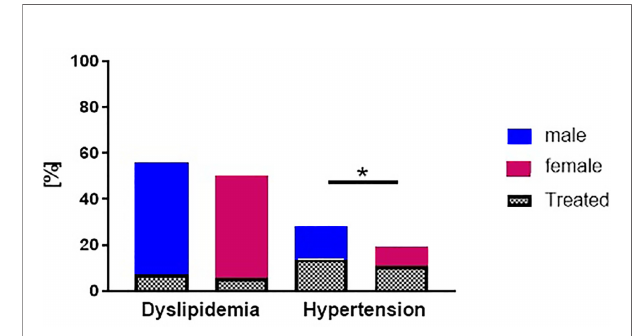
FIGURE 2 | Glucose-lowering medication in patients with newly diagnosed type 1 diabetes from the GDS and DPV cohorts. Choice of glucose-lowering medication in patients with newly diagnosed type 1 diabetes from the GDS (black) and DPV (grey) cohort. Data was collected on the frequency of use of sodium-glucose co-transporter-2 (SGLT-2) inhibitors, dipeptidyl peptidase-4 (DPP4) inhibitors, glucagon-like peptide-1 (GLP-1) receptor agonists, sulphonylureas, metformin and insulin. Data are expressed as percent from the total number of participants in each cohort. P values refer to comparison of unadjusted data. *p < 0.05.